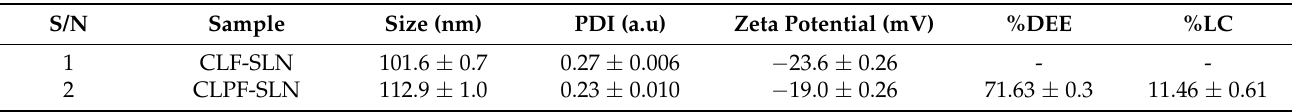
Table 1. Particle size, PDI, the zeta potential of unloaded and PZQ-loaded Compritol-lecithin solid lipid nanoparticles made with PF127, drug entrapment efficacy, and drug loading capacity.